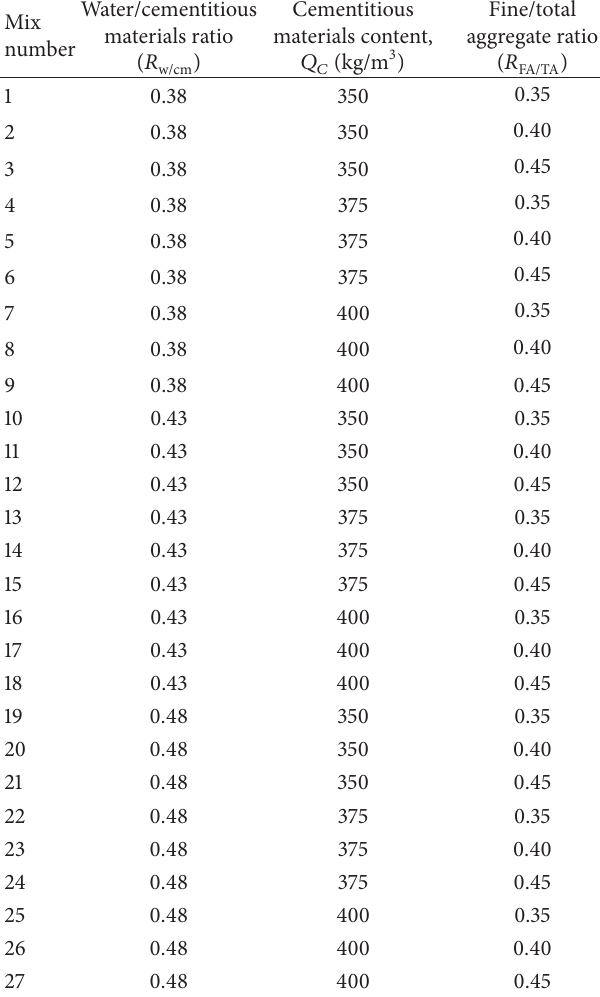
Table 2: Trial mixtures. Table 3: Specific gravity, water absorption, and sieve analysis of aggregates.